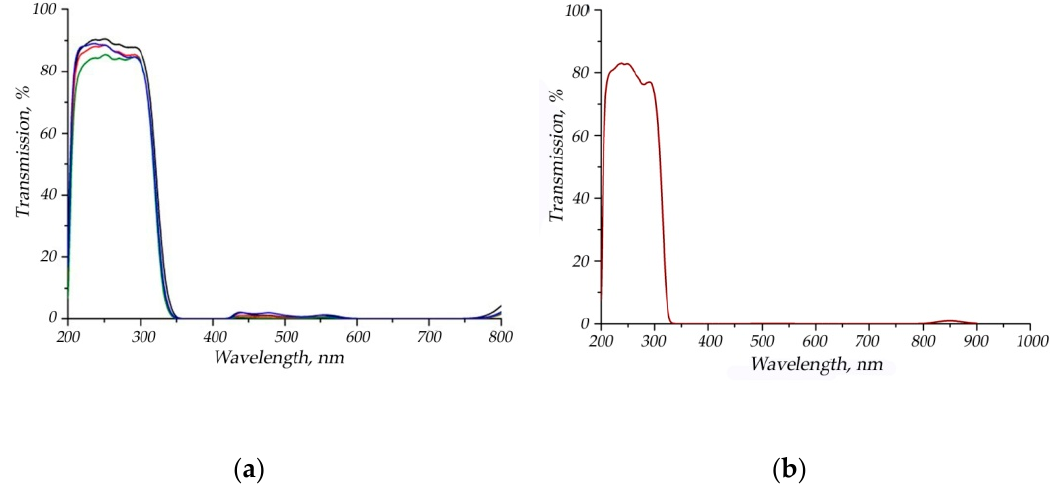
Figure 7. Optical transmission spectra of elements of KCNSH crystals with sample thickness of 10 mm ( a ) and 20 mm ( b ).